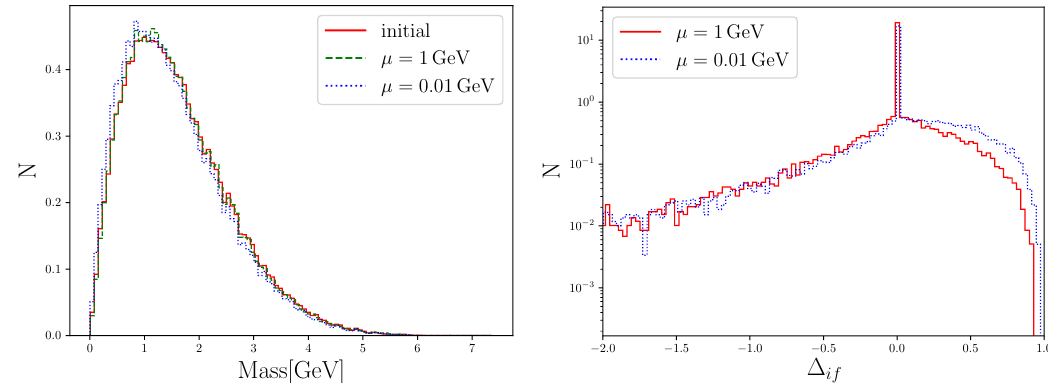
Figure 10 . Distribution of invariant cluster masses before and after colour reconnection and colour length drop for di(cid:11)erent cut-o(cid:11) values of (cid:22) = f 1 ; 0 : 01 g GeV.